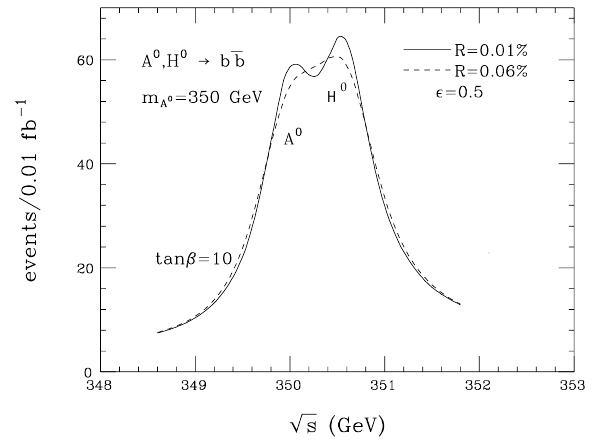
FIG. 8. Separation of A 0 and H 0 signals for tan b (cid:1) 10 . From Ref.